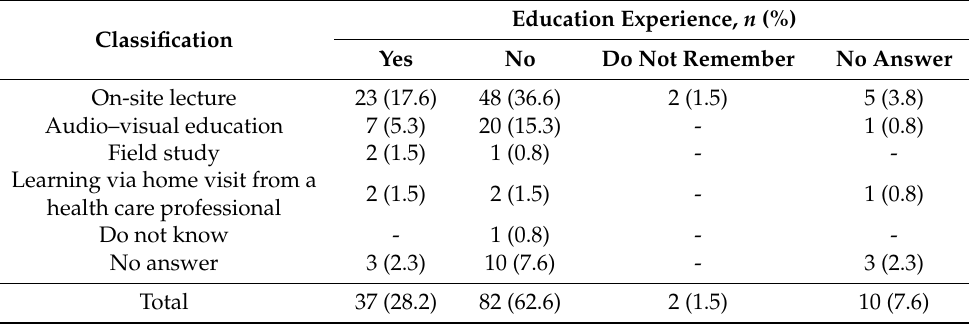
Figure 2. Satisfaction with medication safety education. Table 3. Preferences regarding safe medication education ( n =